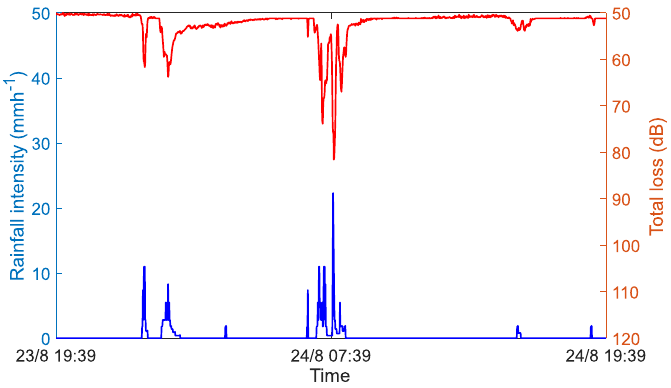
Figure 2. Correlation between CML power total loss and rainfall